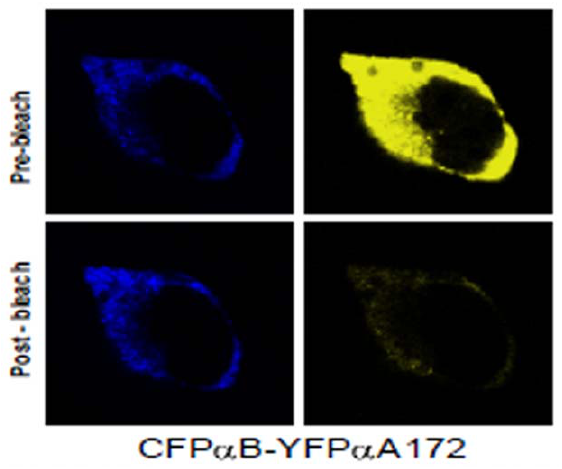
Figure 7. Illustration of the acceptor photobleaching method for determining FRET efficieny. In this example, CFP a Bwt (donor) was co-expressed with YFP a A172 (acceptor). The acceptor fluorescence was bleached by high intensity argon laser light. This resulted in an increase in donor fluorescence intensity and a decrease in acceptor fluorescence.